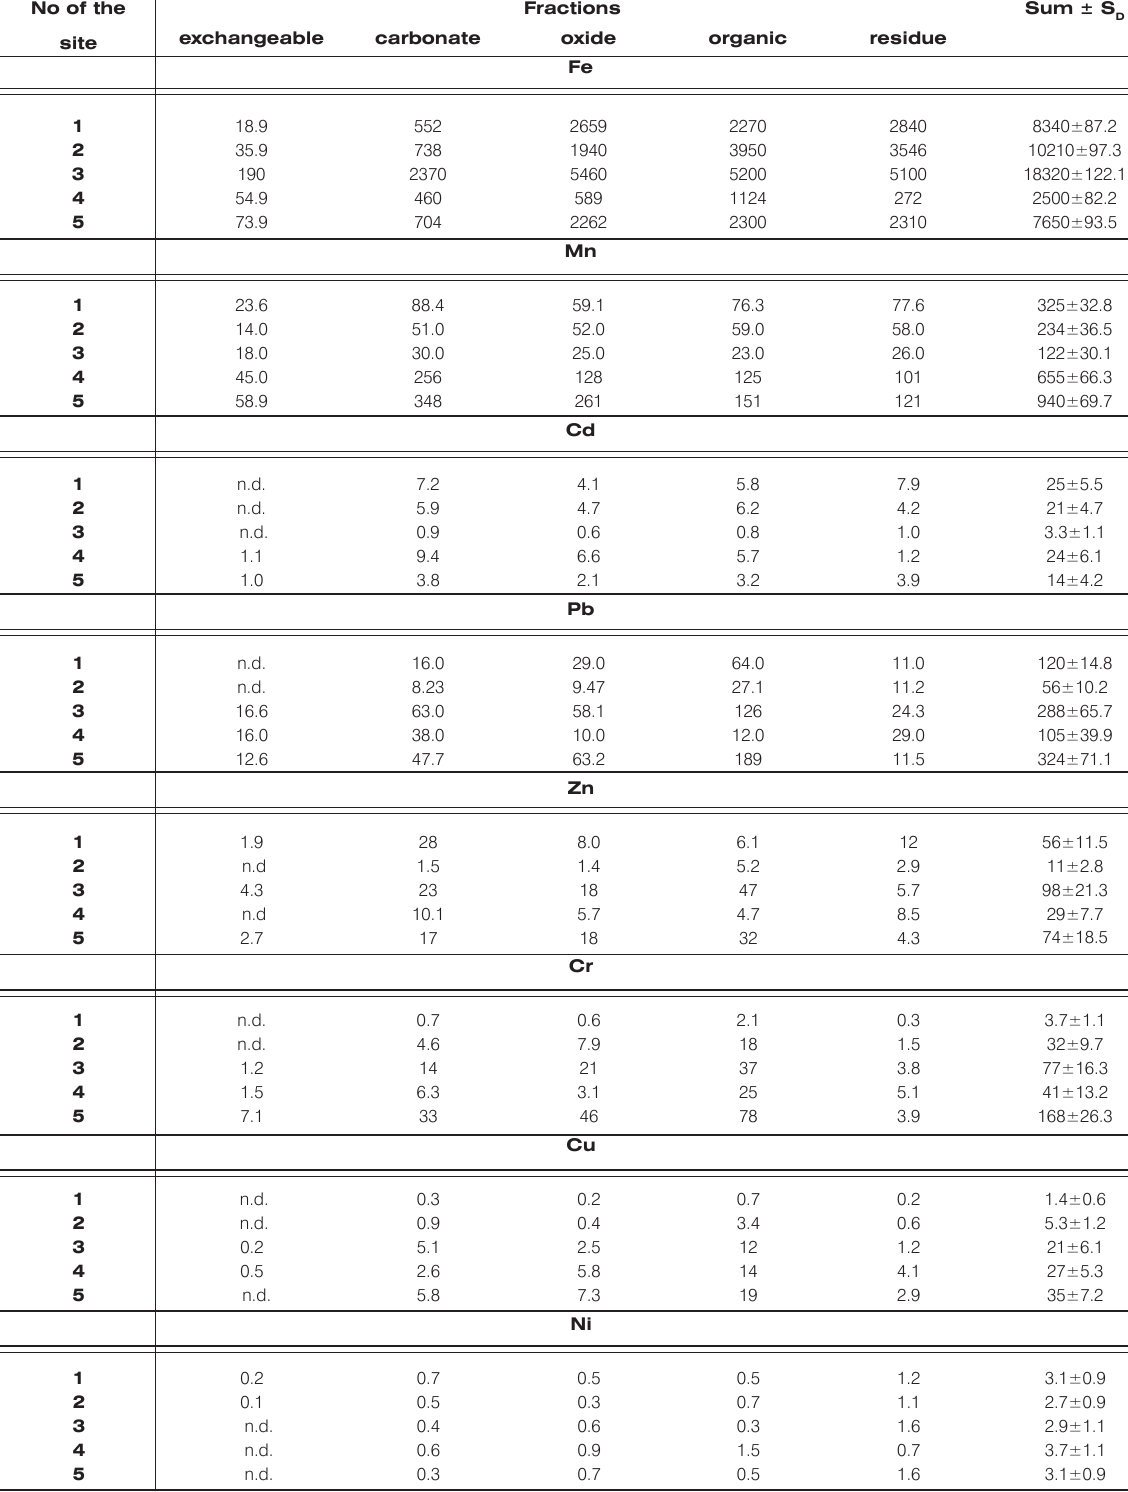
- standard deviation) D